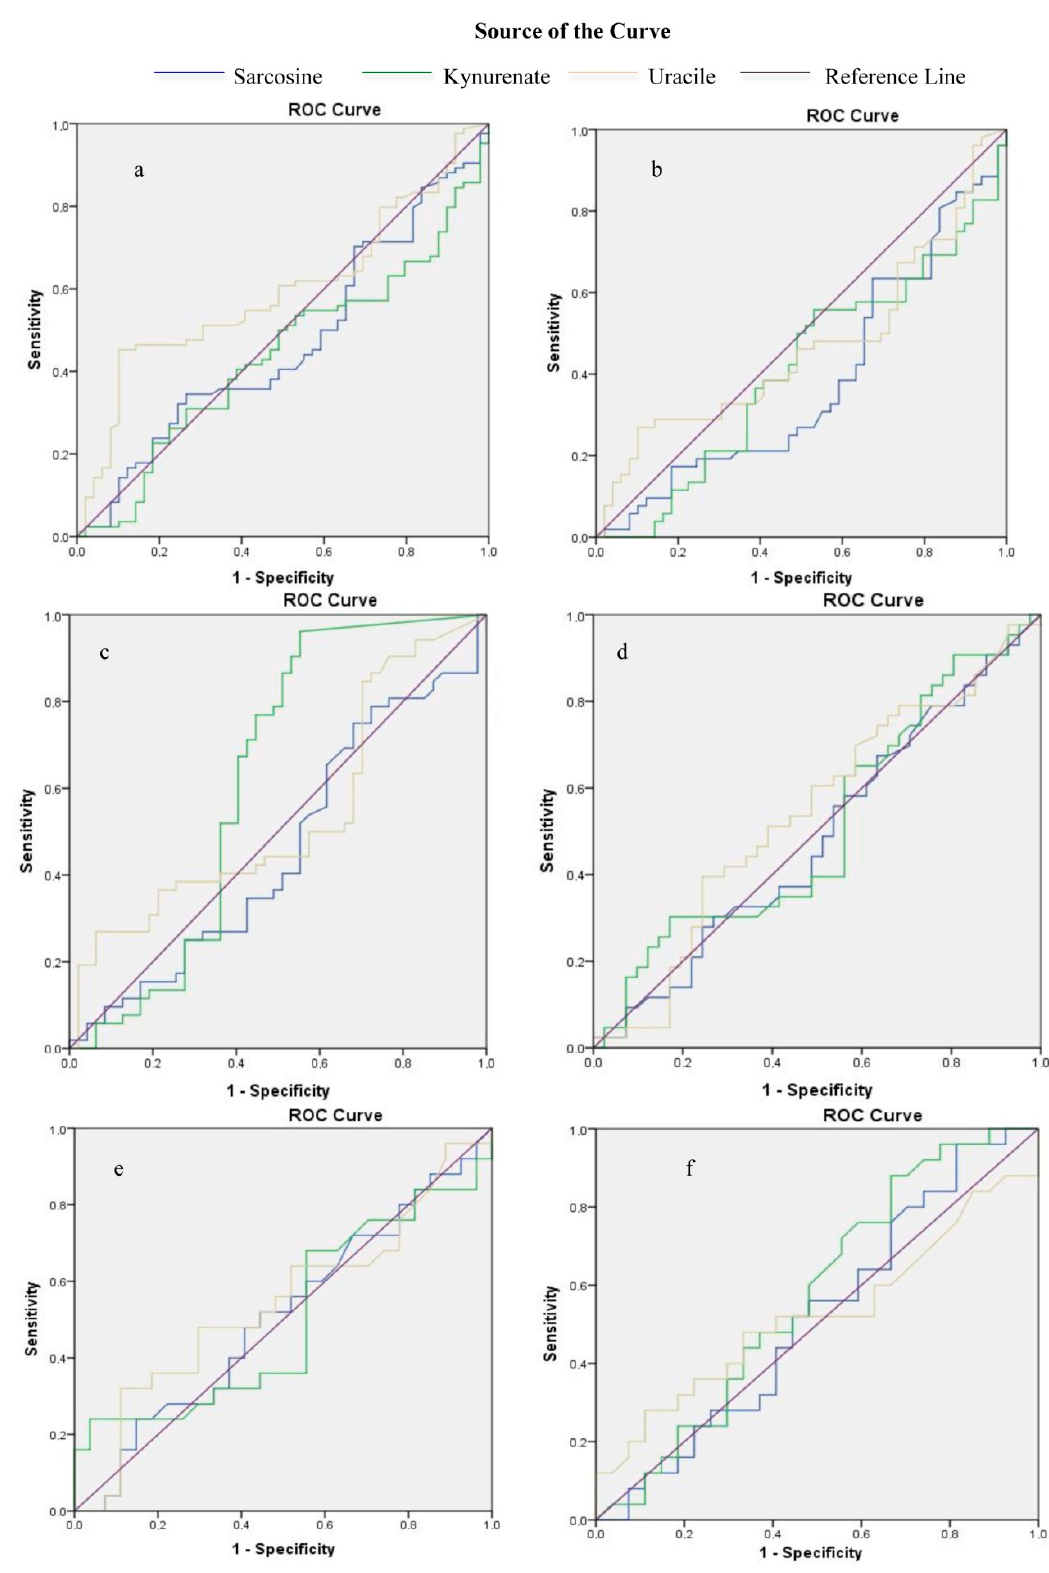
Figure 3. Receiver operating characteristic curves for sarcosine, kynurenic acid and uracil in urine ( a ) in relation to histopathological results; ( b ) in patients undergoing UGPB pre-PM; ( c ) in patients undergoing UGPB post-PM; ( d ) in relation to Gleason Scores; ( e ) in patients undergoing UGPB pre-PM; ( f ) in patients undergoing UGPB post-PM. Dependent variable (a)–(c): prostate cancer risk and (d)–(f): Gleason Score.